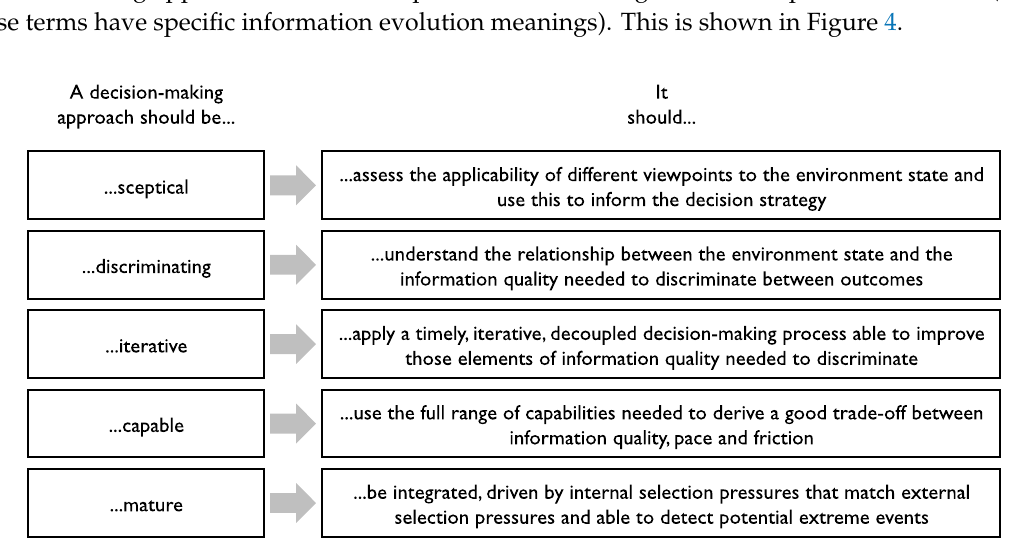
Figure 4. Information evolution characteristics to improve the quality of decision-making.